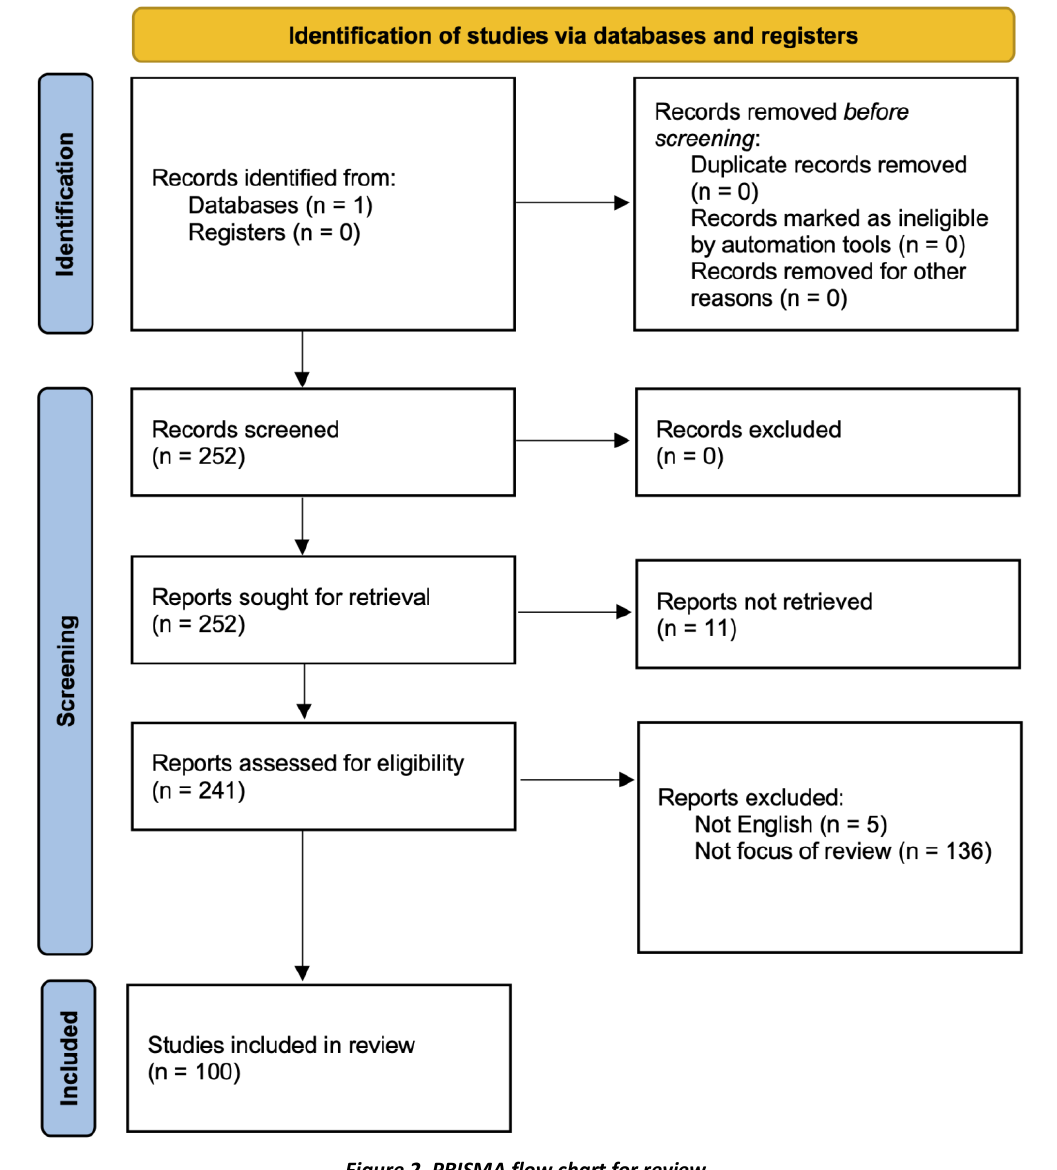
Figure 2. PRISMA flow chart for review